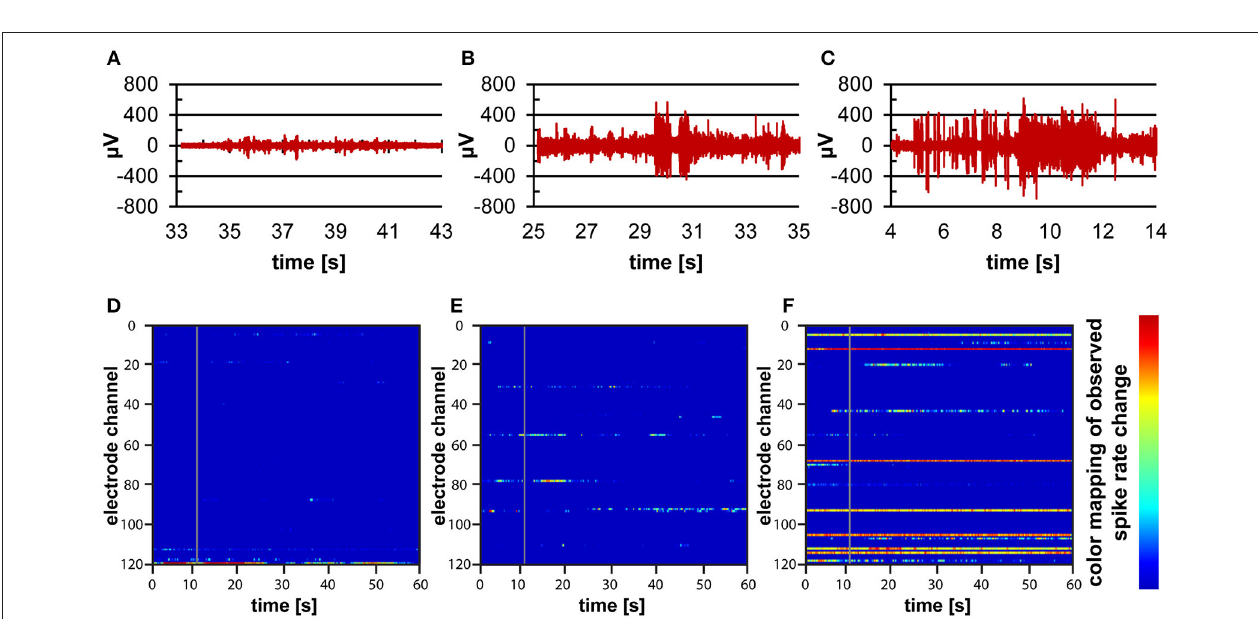
FIGURE 5 | A MEA surface before and after a 3D SH-SY5Y cell experiment in a microbioreactor on top of a MEA. (A) Tile stitched image derived from 2 × 2 images at 4 × magnification of a microbioreactor on top of a MEA prior to the experiment. The dark circle is the porous PES tube that functions as a membrane between the microfluidic channel and the inner culture chamber that is centered on the microelectrodes. Scale bar denotes 1mm. (B) After the long-term cell culture of SH-SY5Y cells inside a microbioreactor on a MEA, the cell culture was removed from the MEA for further analysis. The MEA was cleaned and imaged to assess the debris left after the cell culture. The scale bar denotes 1mm. The image brightness and contrast were increased by 40% to increase visibility.